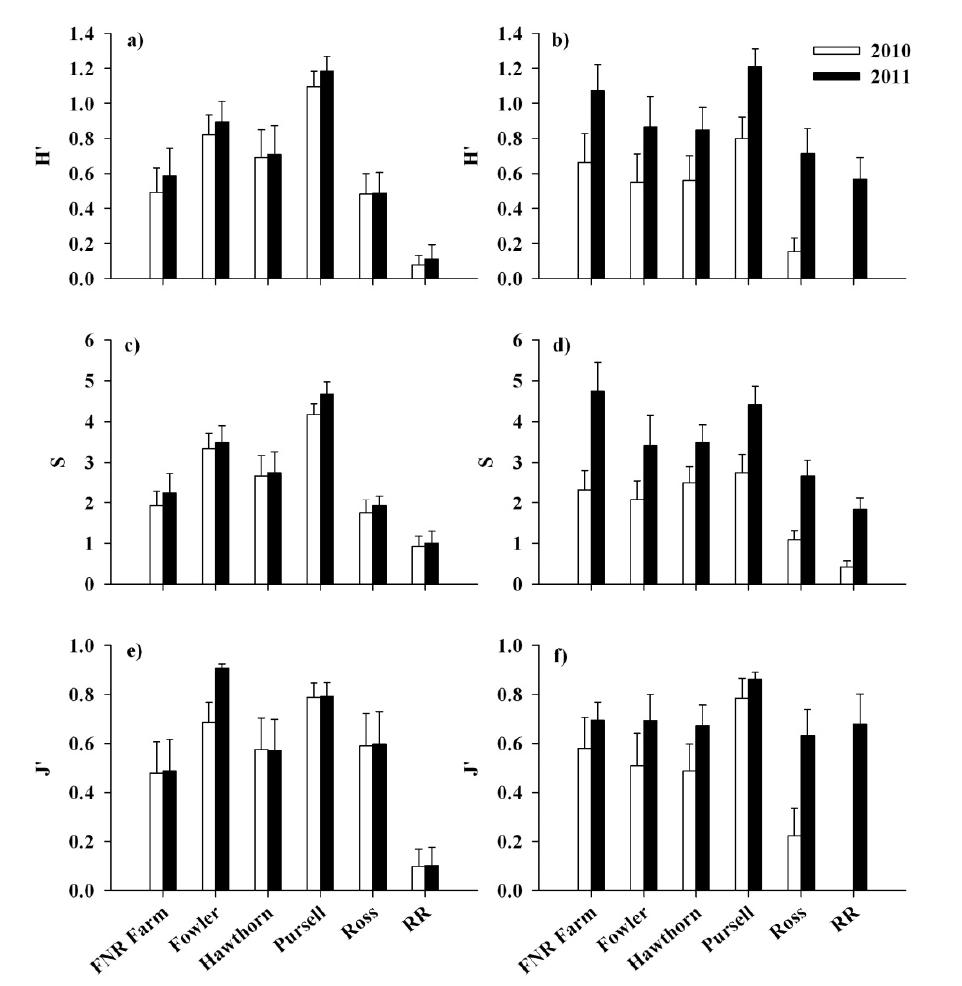
Figure 3. Mean Shannon’s Diversity Index (H') in reference areas ( a ) and removal areas ( b ); mean taxonomic richness (S) in reference areas ( c ) and removal areas ( d ), and mean Pielou’s Evenness Index (J') in reference areas ( e ) and removal areas ( f ) during the spring seasons of 2010 and 2011 at six mixed-hardwood forests in central Indiana. Error bars are ±1 SE. Indices were based on percent cover data from native herbaceous species that flower primarily during the